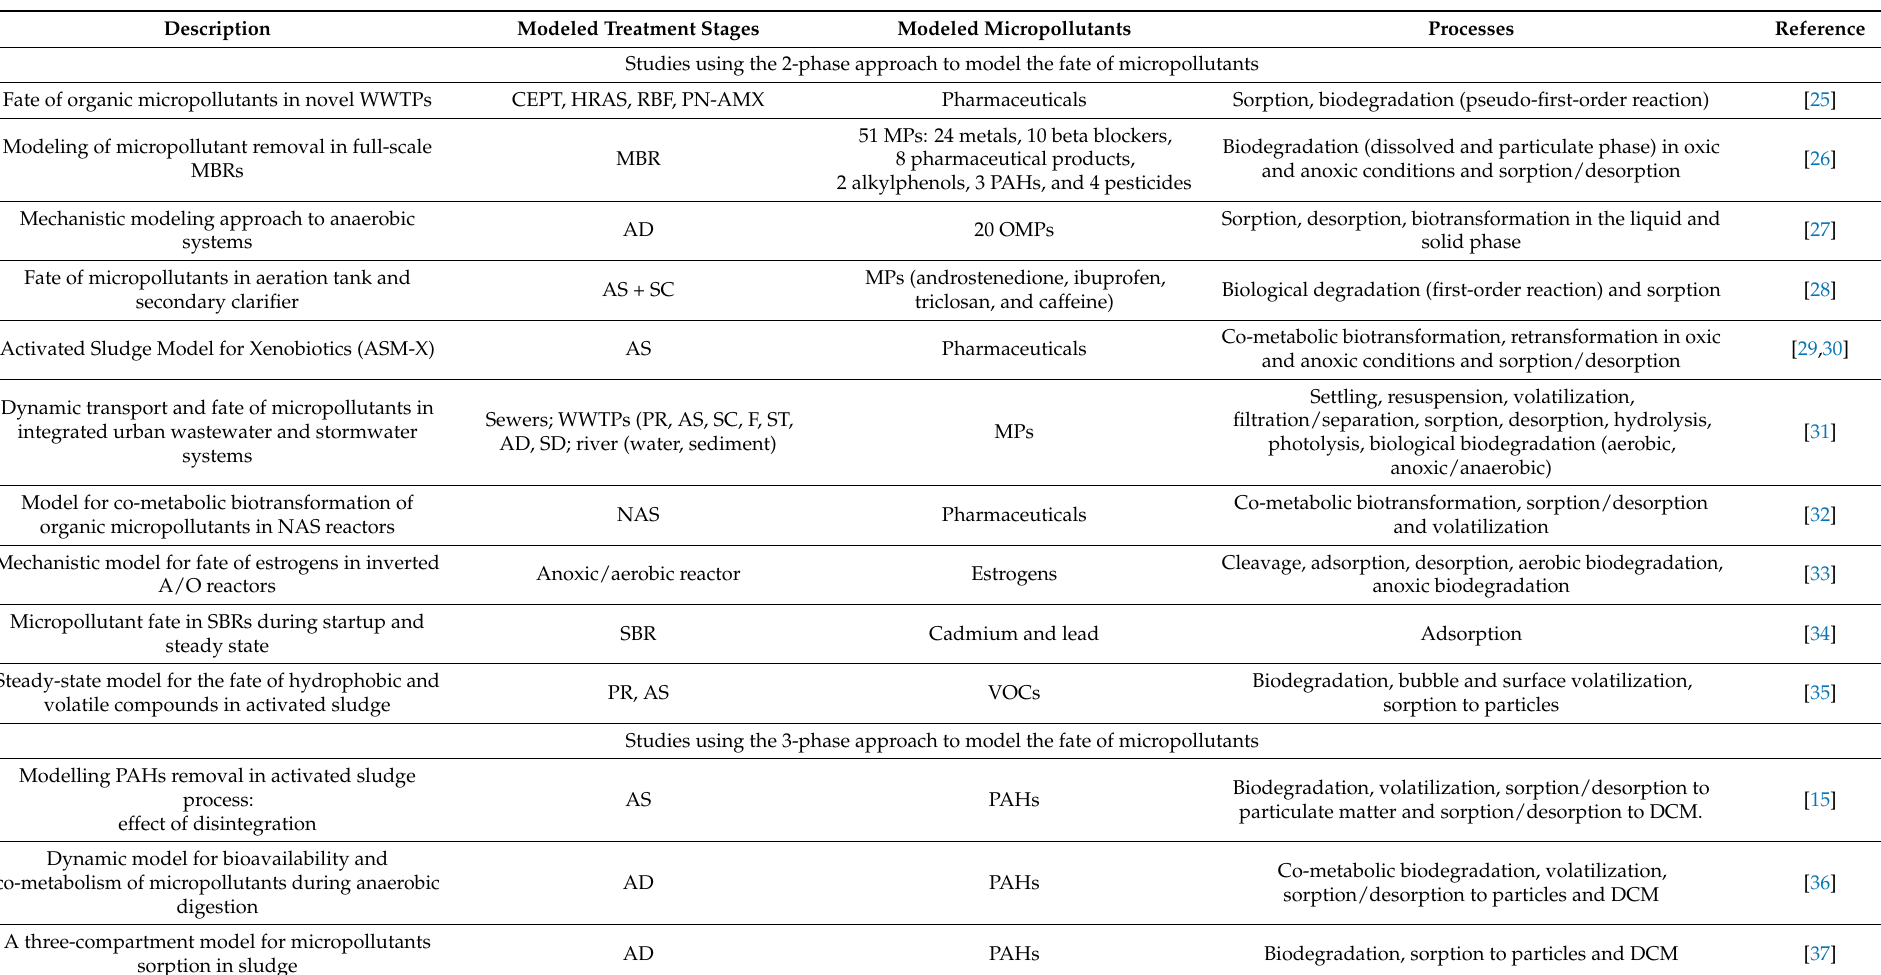
Table 2. Summary of studies focusing on modeling the fate of different micropollutants in wastewater